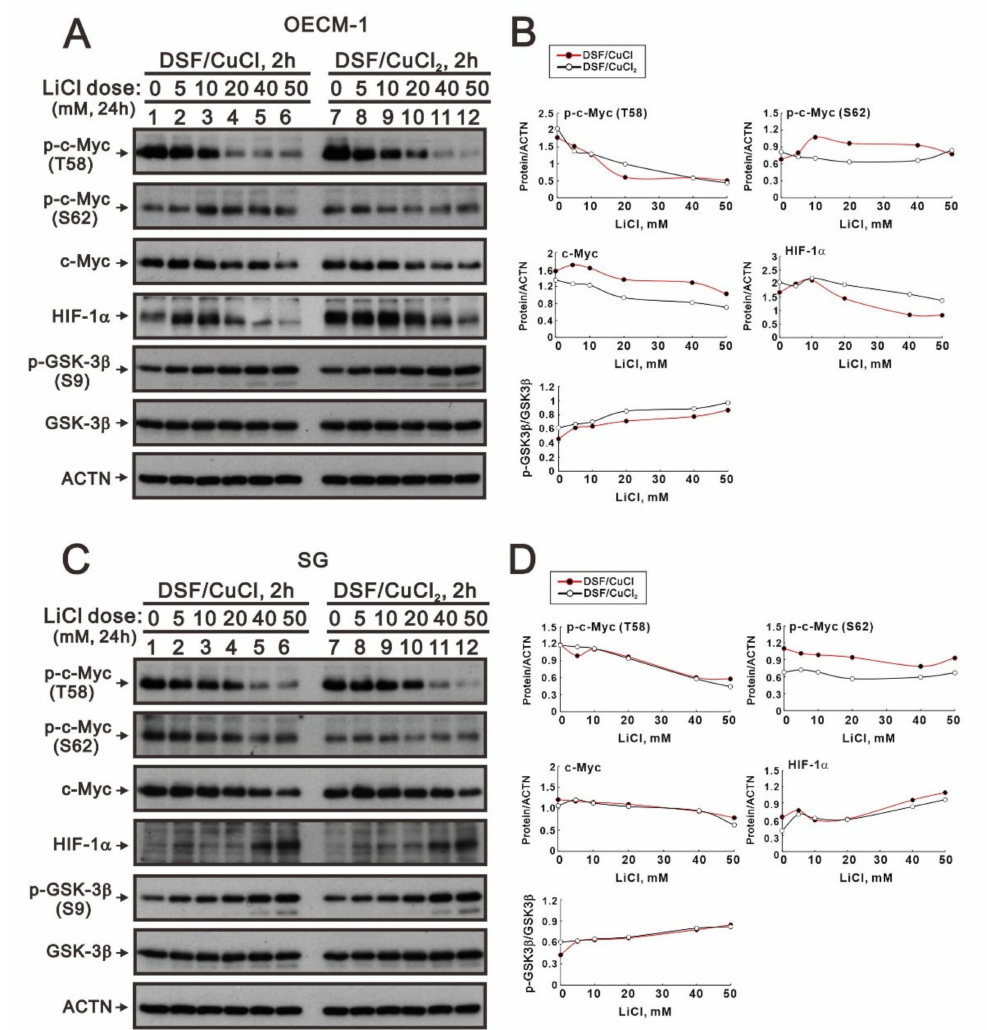
Figure 6. The effects of DSF, copper ions, and DSF/copper complexes on the c-Myc and HIF-1 α proteins in LiCl-treated OECM-1 and SG cells. ( A ) OECM-1 and ( C ) SG cells were treated with 50 µ M of CuCl 2 plus 0.5 µ M of DSF or 2 µ M of CuCl plus 0.5 µ M of DSF for 2 h, accompanied by 0, 5, 10, 20, 40, and 50 mM LiCl for 24 h. The cell lysates were subjected to Western blot analysis using antibodies against the indicated proteins. ACTN was a loading protein control. The protein bands ( A , C ) were quantified through pixel density scanning and evaluated using ImageJ, version 1.44a (http://imagej.nih.gov/ij/) (accessed on 1 May 2022). The ratios of protein/ACTN and pGSK3 β /GSK3 β were plotted, and red lines are for the DSF/CuCl complexes and black lines for the DSF/CuCl 2 complexes in ( B ) OECM-1 and ( D ) SG